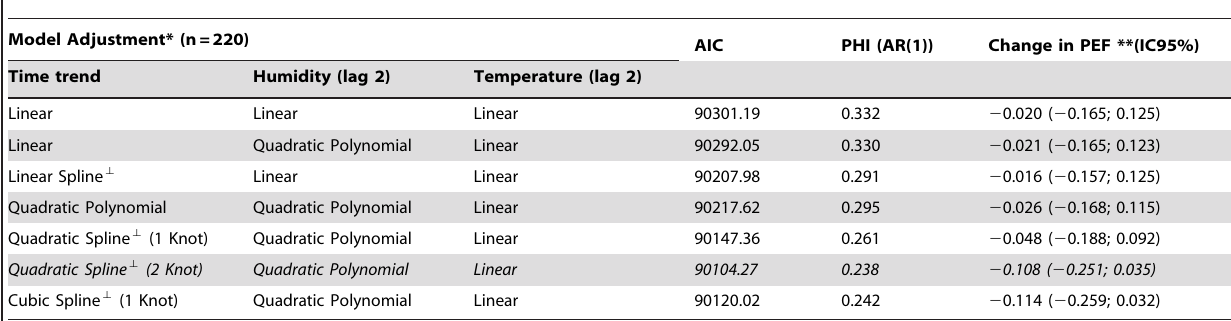
Table 4. Summary adjustment strategies of the mixed-effect